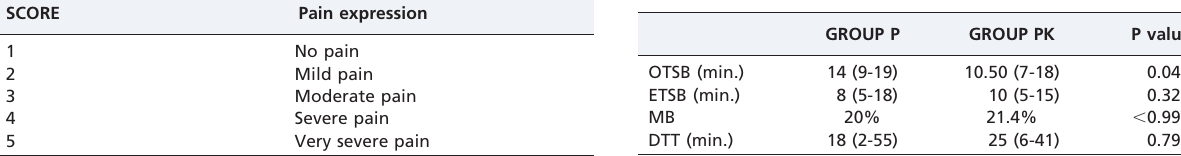
Table 3 - Onset time of sensory block (OTSB), end time of sensory block (ETSB), presence of motor block (MB), duration of tourniquet tolerance (DTT) (median value,